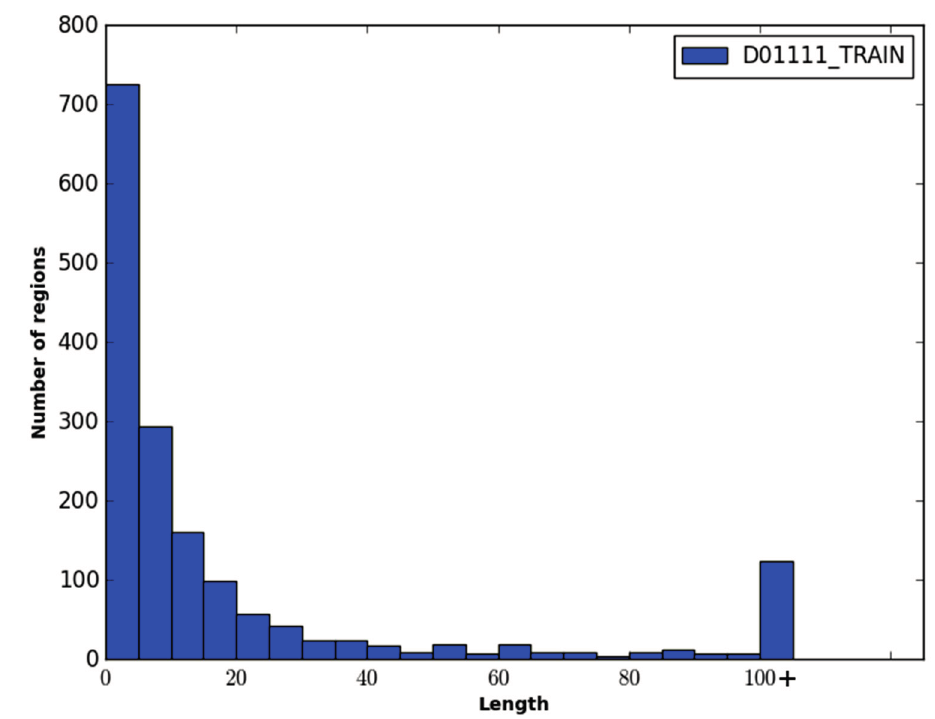
Figure 8. Distribution of the length of disordered regions in the DO1111_TRAIN. Each bin represents a range of five residues, and the last bin represents the number of disordered regions that have a length greater than 100